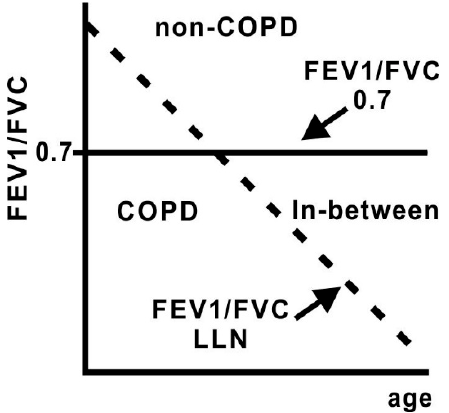
Figure 1. Diagram depicting the fixed 0.7 ratio of FEV1/ FVC and the decline of the LLN of FEV1/ FVC with aging. Modified from Reference 42. Solid line: the fixed 0.7 ratio. Dotted line: the LLN of FVC with aging. Modified from [42]. Solid line: The fixed 0.7 ratio. Dotted line: The LLN of FEV1/ FEV1/ FVC with aging. FVC with